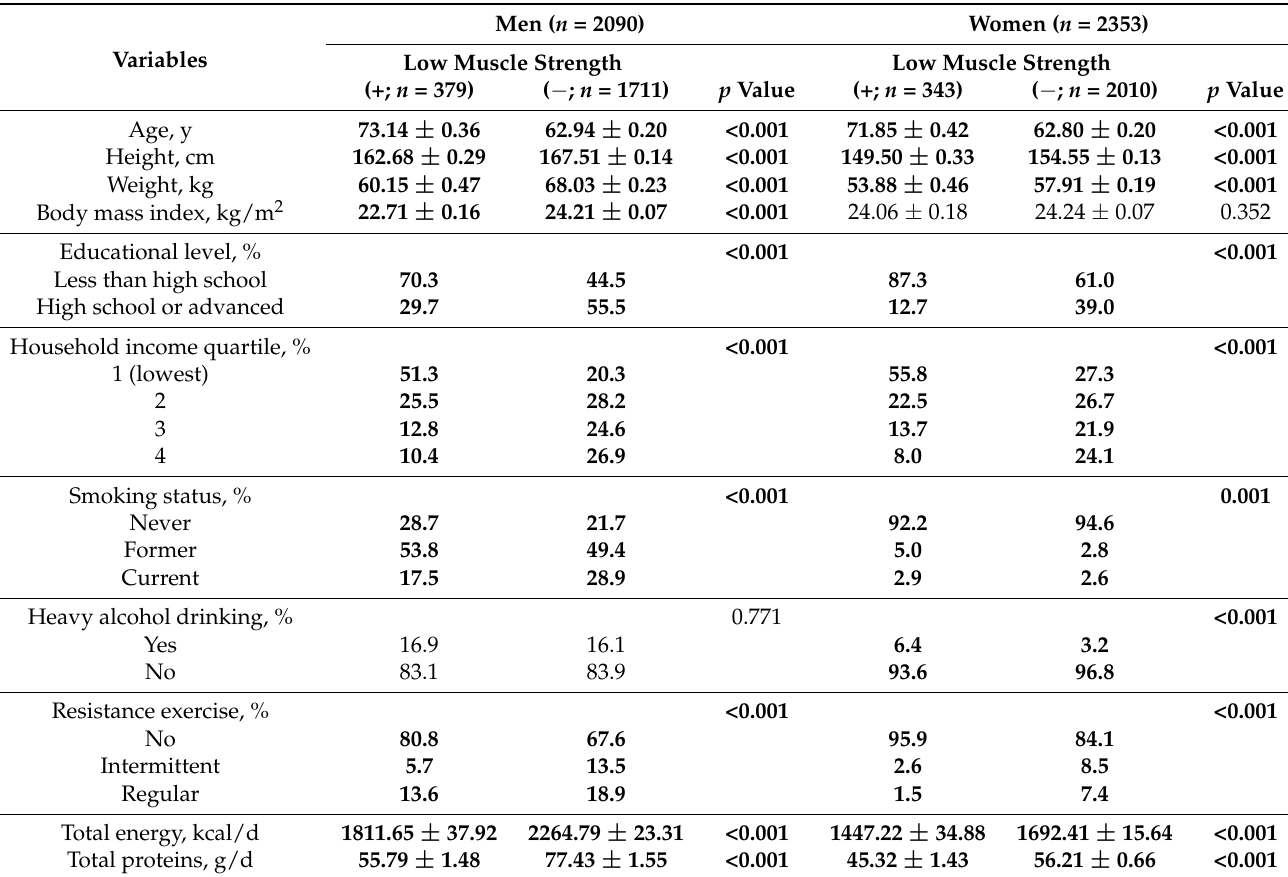
Table 1. Baseline characteristics of the study